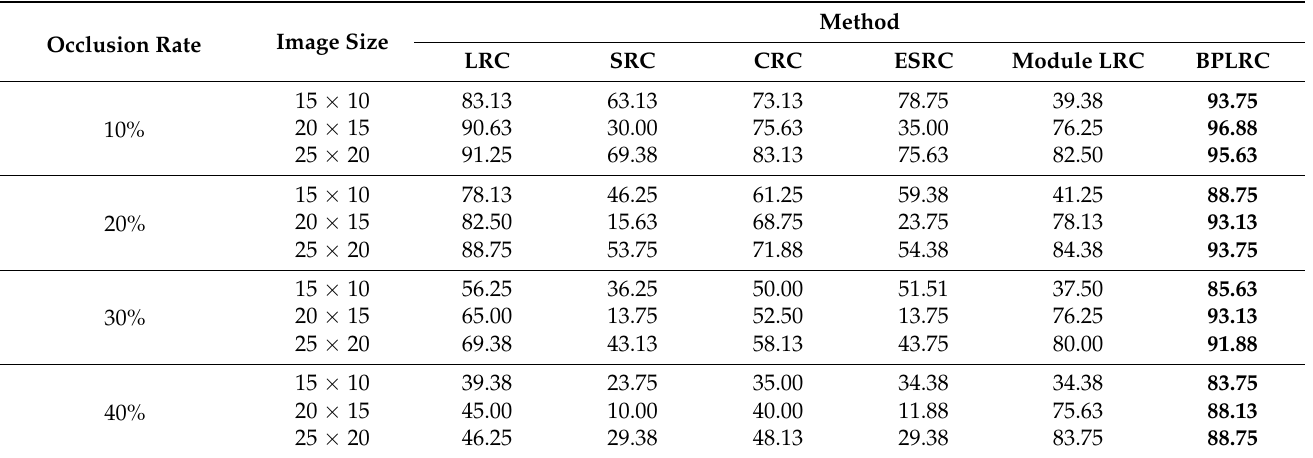
Table 7. Accuracy (%) of different methods when identifying 10%-, 20%-, 30%-, and 40%-occluded face images from the ORL database.